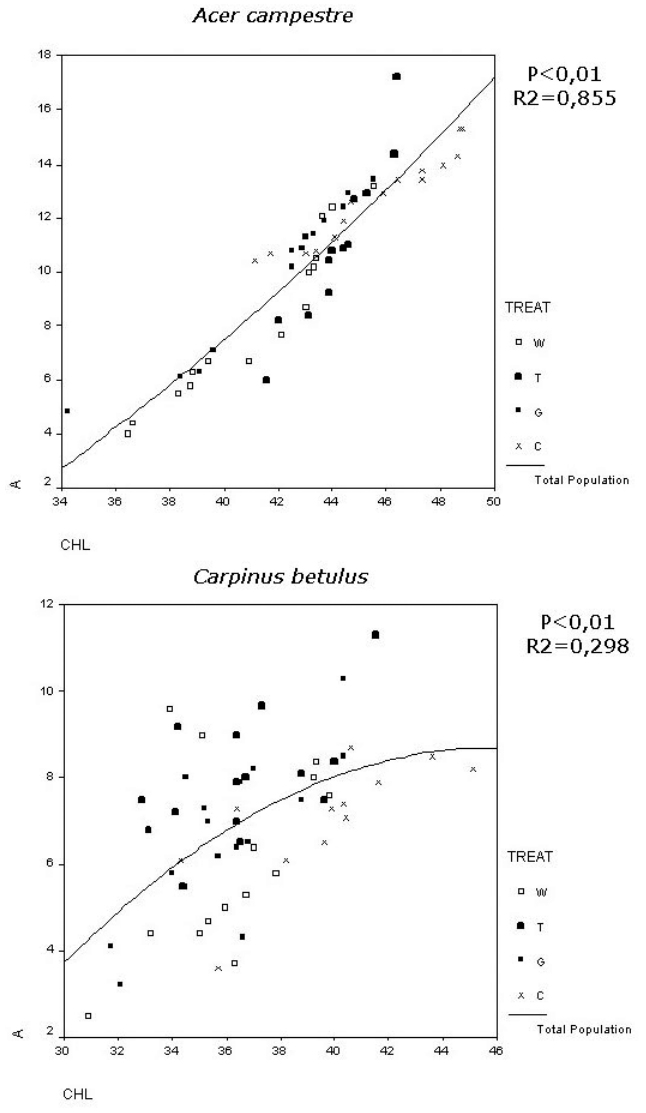
Fig. 2 - Relationship between leaf greenness index (chl, SPAD-units) and net assimilation (A, mmol*m -2 *s -1 ) in Acer campestre and Carpinus betulus.